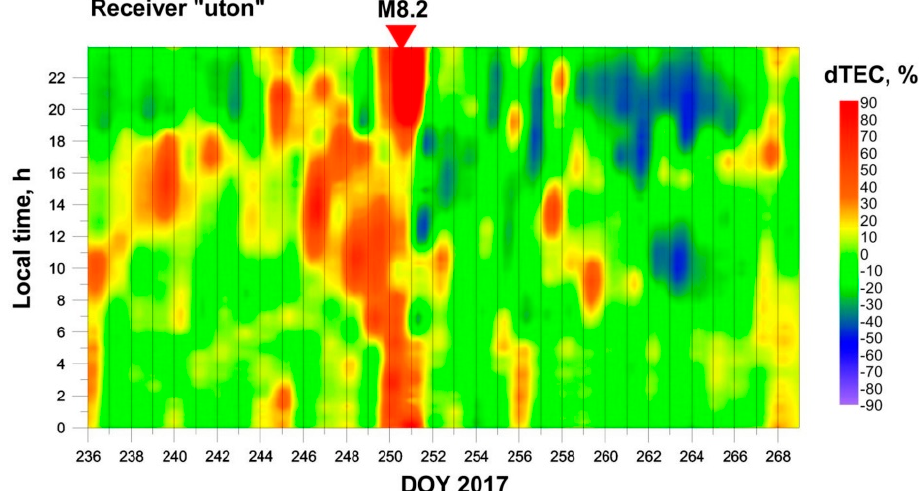
Figure 3. Ionospheric earthquake precursor mask for the Mexico region: along the abscissa, the days of year 2017 starting from 24 August (236) to 25 September (268) are marked. The day of the 8.2 Mw earthquake on 8 September (251) is also denoted. Tone scale shows the values of Δ TEC (%).